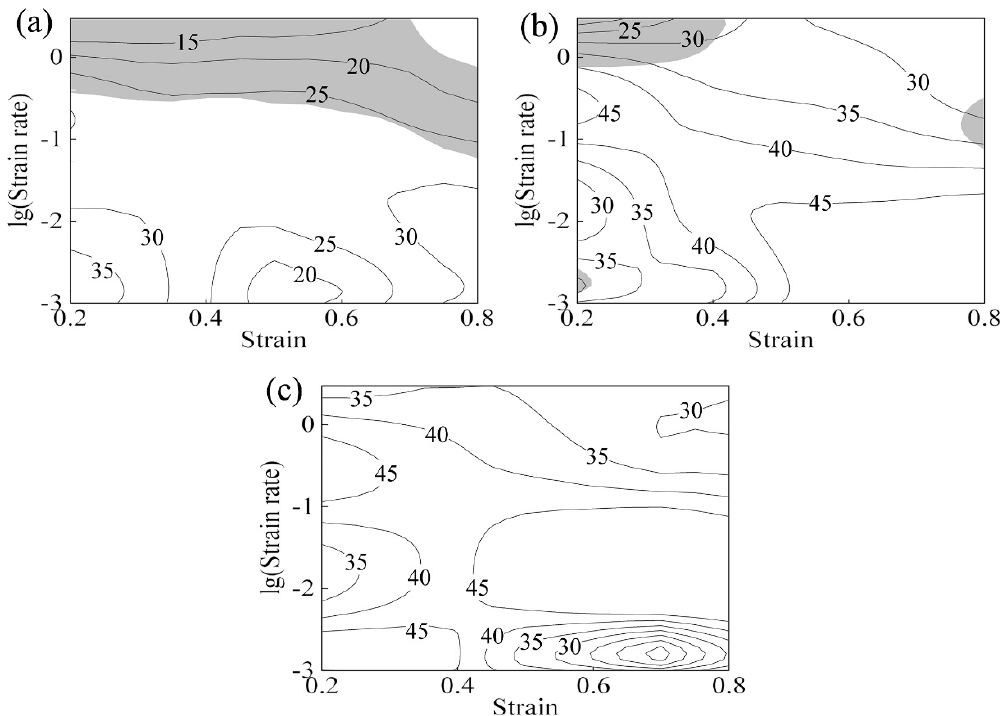
Figure 8. Processing maps of GH4698 at the temperatures of ( a ) 950 °C, ( b ) 1050 °C, and ( c ) 1150 °C.